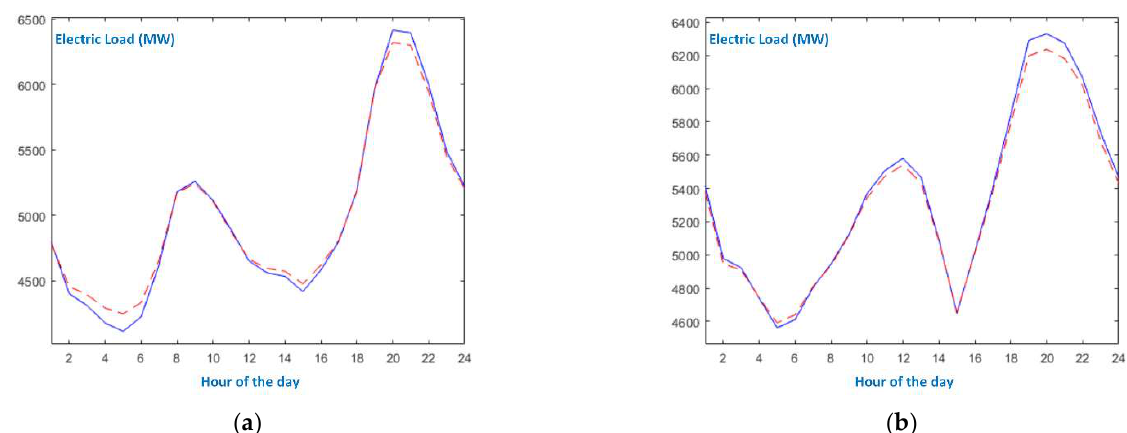
Figure 5. Presentation of winter days. The blue solid line is the actual electric load, and the red dotted line is ReNFuzz-LF’s output: ( a ) working day; ( b ) Sunday.